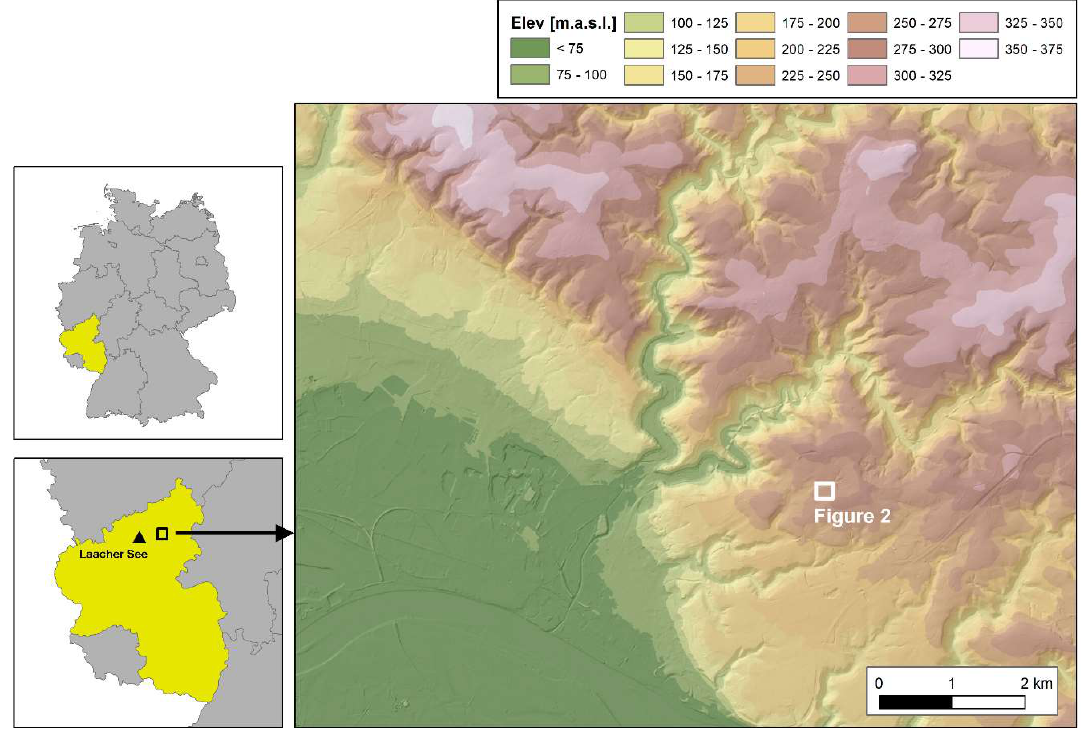
Figure 1. Location of the study